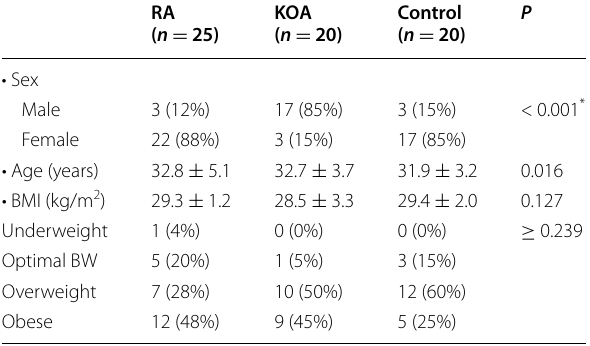
Table 1 Comparison between the studied groups according to different parameters